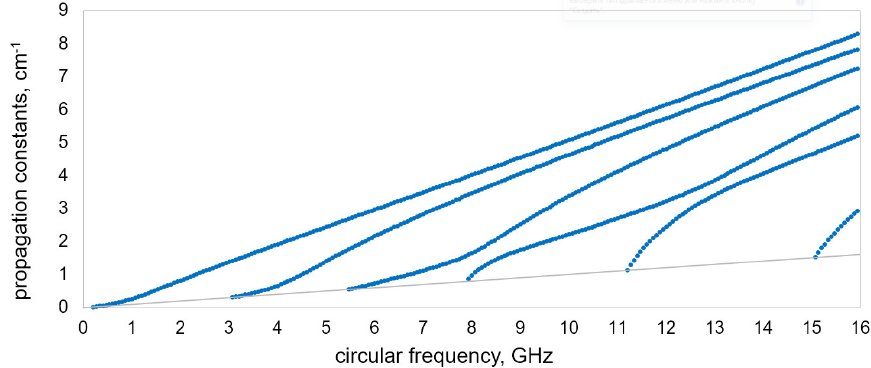
Figure 2: Dispersion curves for the values of the components of the tensor ^ (cid:22) : (cid:22) (cid:26) = 1 ; (cid:22) z = 1; (cid:22) φ = 0 . The red curves correspond to TM-polarized waves, the green curves to TE-polarized waves.